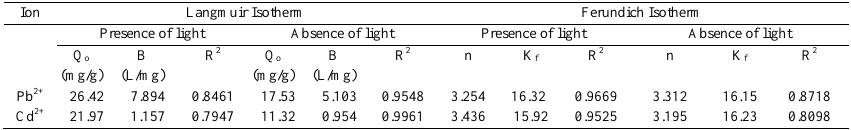
Table 7. Langmuir and Freundlich isotherm constants for the adsorption of lead (II) and cadmium (II) ion by Ce-TiO 2 /bentonite nanocomposite